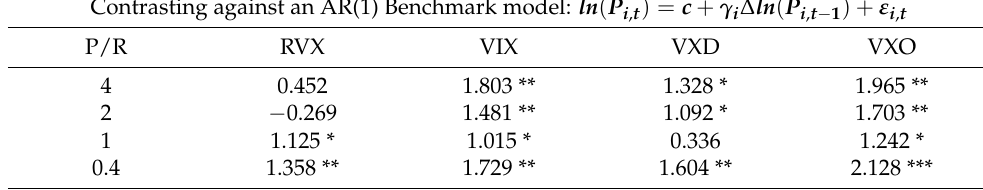
Table 1, row 3). We report four estimation windows with the following critical values: P/R = 4 used critical values 1.540, 2.561, and 5.087 for p < 10%, p < 5%, and p < 1%, respectively. P/R = 2 used critical values 1.280, 2.085, and 4.134 for p < 10%, p < 5%, and p < 1%, respectively. P/R = 1 used critical values 0.984, 1.584, and 3.209 for p < 10%, p < 5%, and p < 1%, respectively. P/R = 0.4 used critical values 0.685, 1.079, and 2.098 for p < 10%, p < 5%, and Table 5. Forecasting stock market implied volatility with financial reports tone disagreement: Out-of- sample analysis with the ENC-t